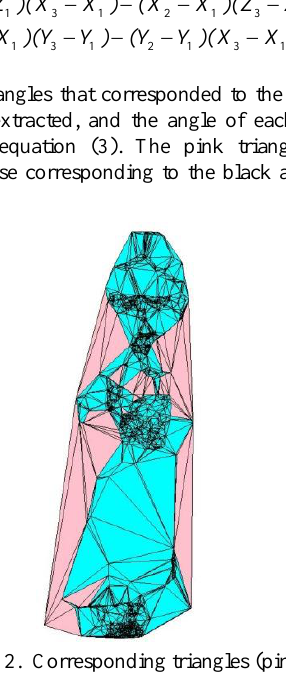
Figure 12. Corresponding triangles (pink).